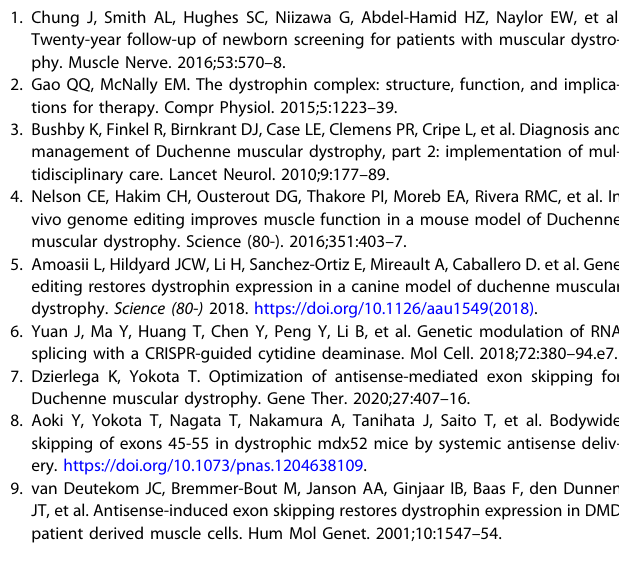
Fig. 7 Histopathological analysis of muscles treated with 2OMePS/PEI polyplex-loaded PF microspheres. A H&E staining of cryosections of the TA muscles of mdx mice 30 days after intramuscular (IM) injection, empty PF microspheres (PF empty), free 2OMePs/PEI polyplexes (2OMePS) or 2OMePS/PEI loaded PF microspheres (PF + 2OMePS), and the non-treated (NT) group. Muscles treated by intra-femoral (IF) injection were also stained and compared to non-treated (NT) mdx mice 20- and 40-days post injections. The 20 days non-treated mdx mice (NT-20d) are compared to 20 days IF-treated mice (PF + 2OMePS-20d) and the 40 days non-treated mdx mice (NT-40d) are compared to 40 days IF treated mice (PF + 2OMePS-40d). Representative images are shown with a scale bar = 100 µm. B Average in fl ammation score analyzed from TA muscle sections after Intramuscular injection (IM) and intra-femoral injection (IF); the scoring date ( n = 3) is presented as mean ± SD. C Percentage of centrally nucleated muscle fi bers (CNFs) counted in TA cryosections after Intramuscular injection (IM) and intra- femoral injection (IF). Data ( n = 3) is presented as mean ± SD; ** P < 0.01, * P < 0.05 compared to NT mdx